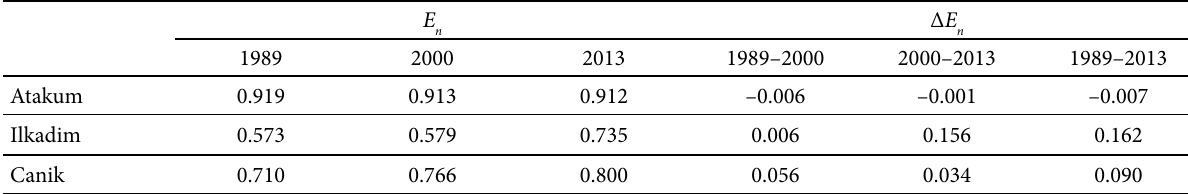
Figure 4a and at the direction level using sliced directions.